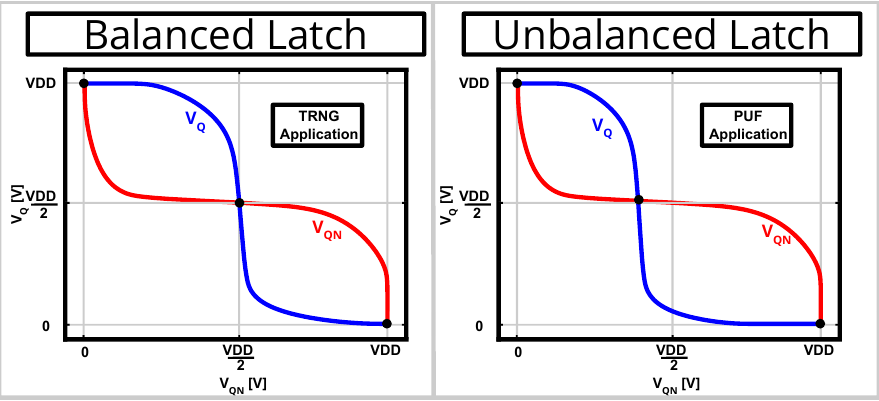
Figure 6. Metastability response in balanced and unbalanced